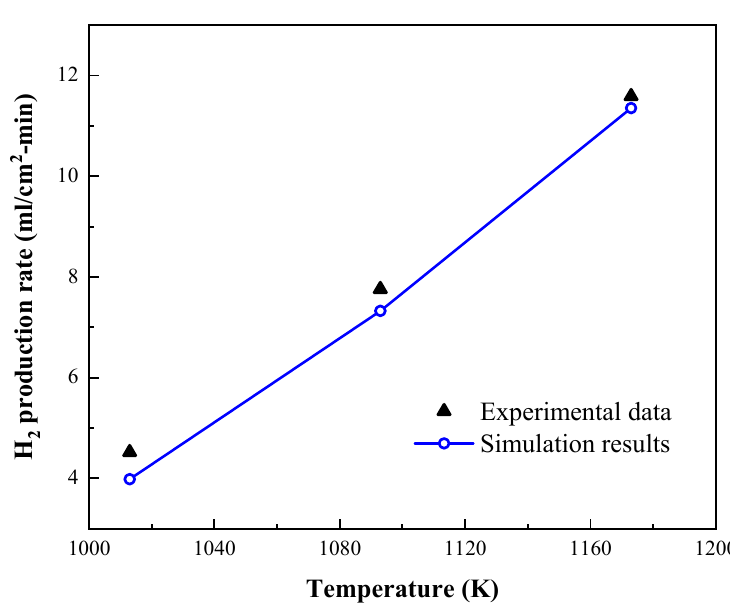
Figure 3. Schematic diagram of the second model used for validation.